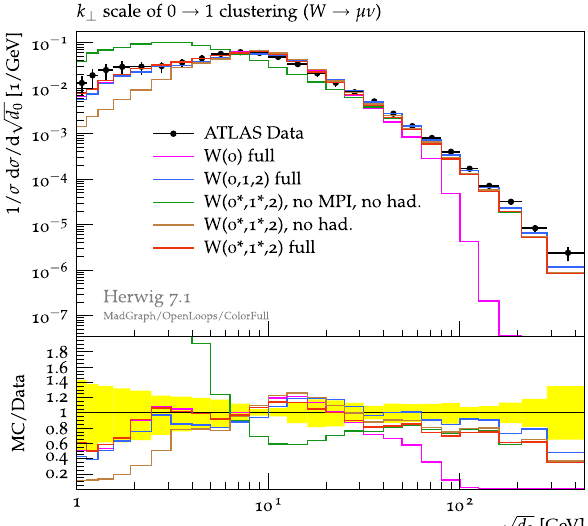
Fig. 23 d 0 isameasureforthehardnessofthefirstemissionwhichwas measured at the ATLAS experiment [71]. While the MEs are needed to fill the phase space of hard emissions, the MPI model and hadronization are needed to model the lower scales of the spectrum